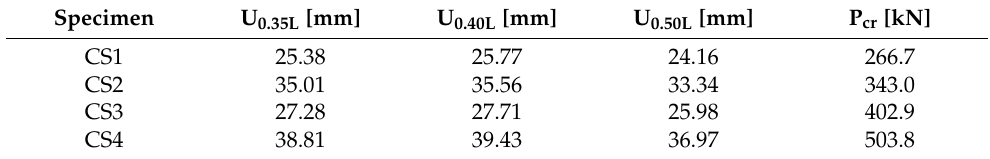
Table 2. Measured horizontal displacements at 0.35 L, 0.40 L, 0.50 L and the critical buckling force.